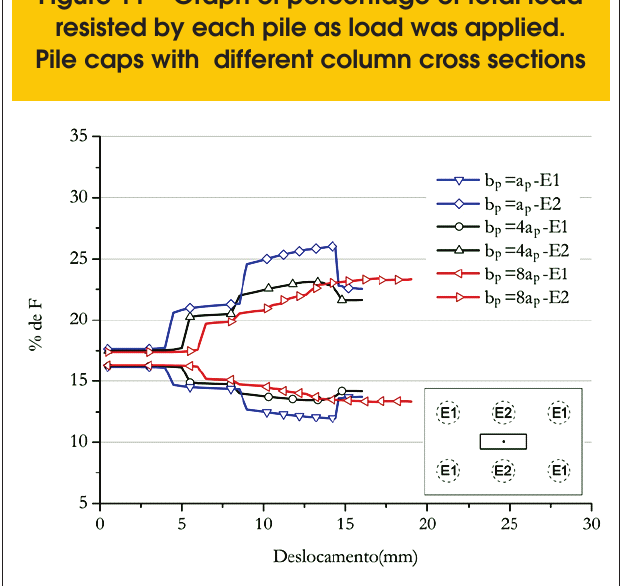
Figure 12 – Graph of load versus displacement applied considering different column cross sections